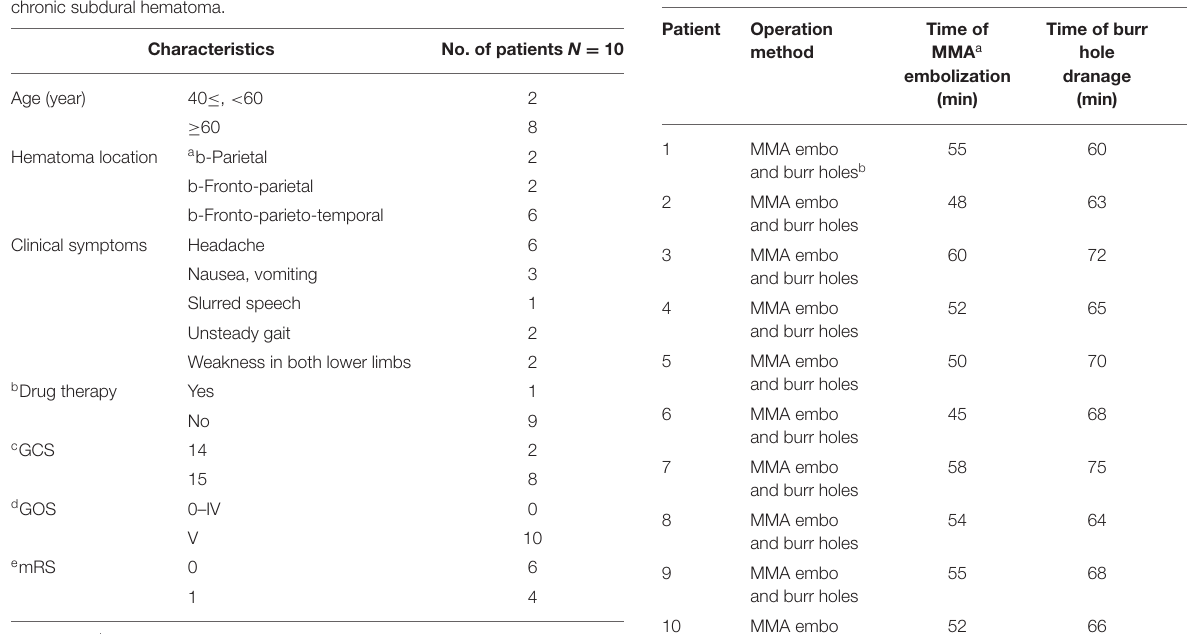
TABLE 2 | The patient’s operation method, operation time and follow-up